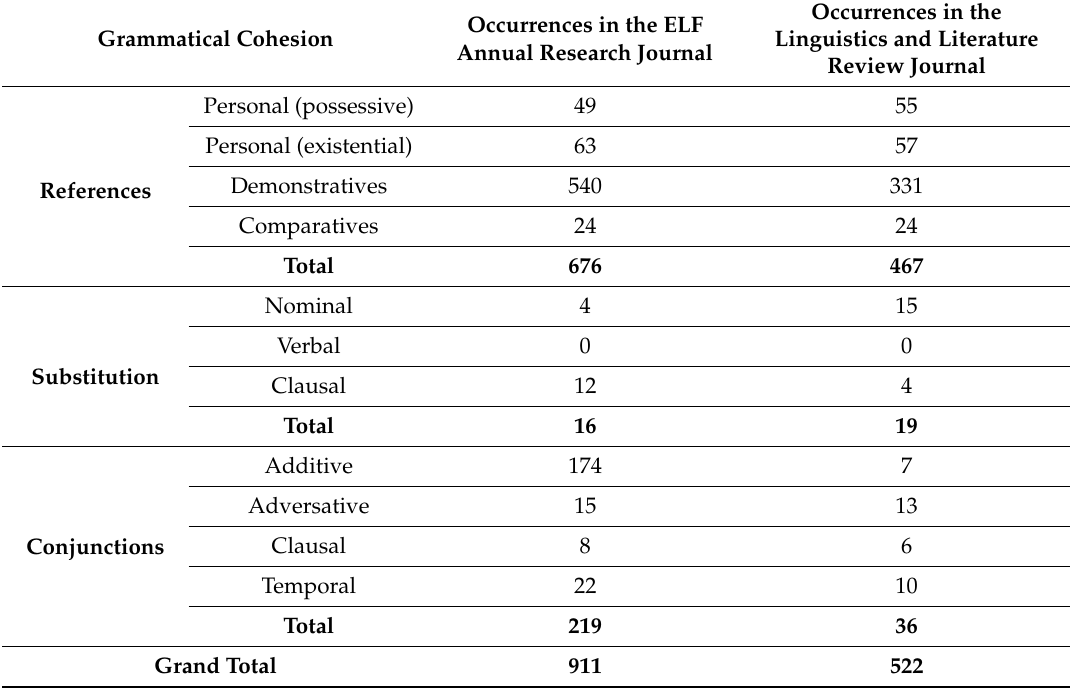
Table 27. Comparison between the frequencies of grammatical cohesion in the data from the ELF Annual Research Journal and the Linguistics and Literature Review Journal.